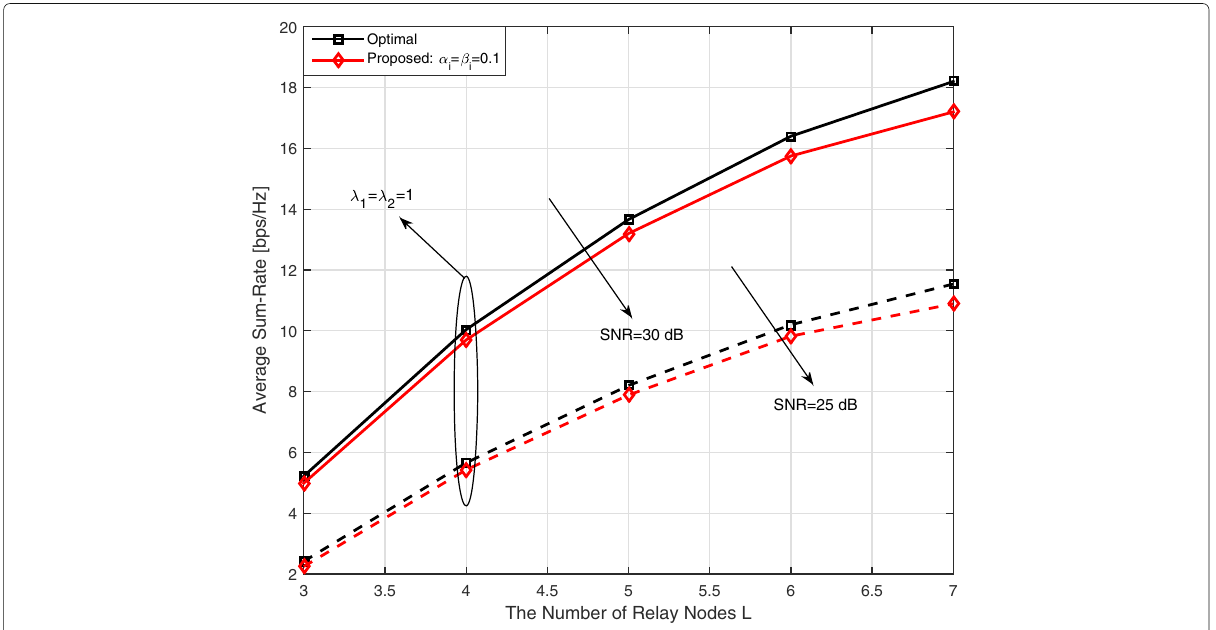
Fig. 4 The average weighted SR versus the number of relay L